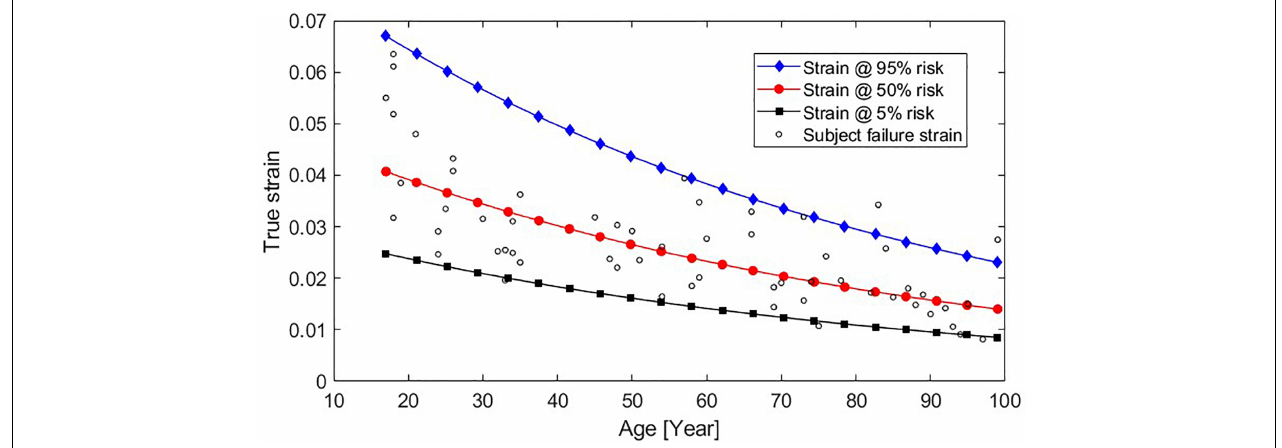
FIGURE 6 | Strains that result in 95, 50, and 5% predicted fracture risk across subjects aged 17–99 years, using the newly developed function plotted with the failure strain and age data from each